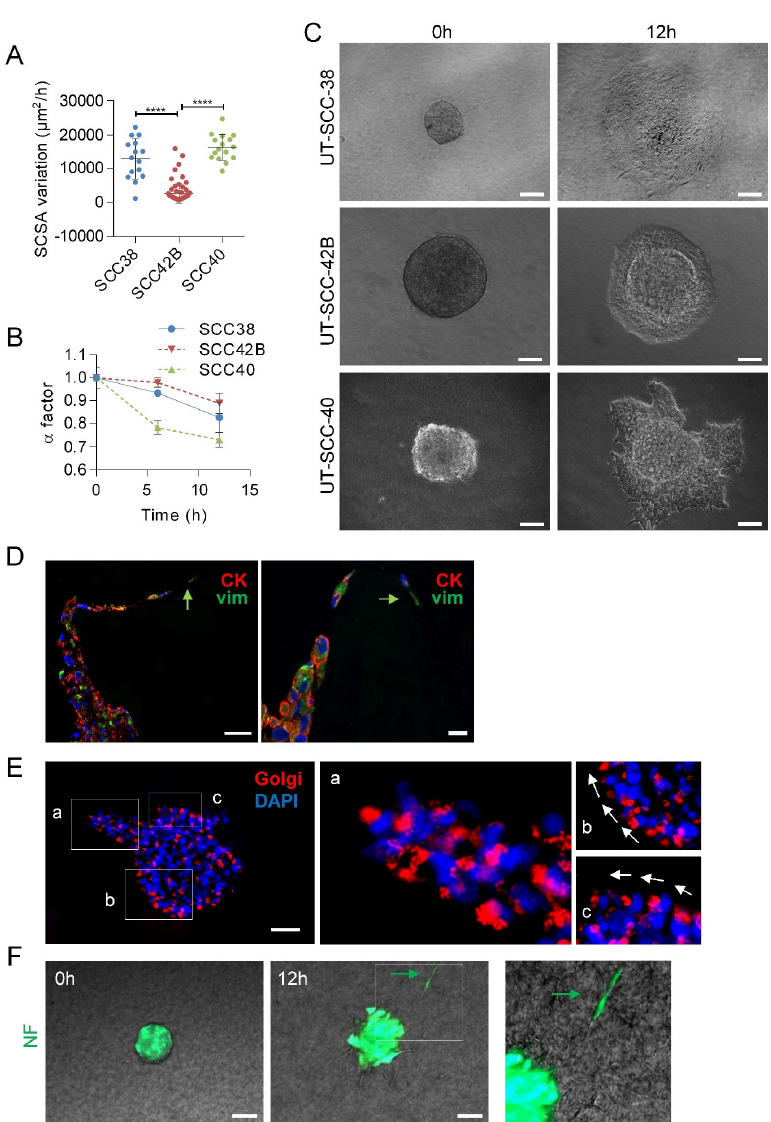
Figure 2. Collective migration of different SCC cell lines showing the driver role of mesenchymal cancer cells over epithelial cells. ( A ) Variations over time of the spheroid cross sectional areas (SCSA) were measured for 12 h in spheroids of the indicated cell lines to calculate the velocity of the migration. Mean and standard deviation values were calculated from 15, 68 and 16 individual spheroids in 3 different experiments for UT-SCC-38, UT-SCC-42B and UT-SCC-40 cells, respectively. **** indicates p < 0.0001. ( B ) Variation over time of the α factor for the indicated cell lines. Data are presented as mean value ± standard deviation from 3 experiments and 10–20 spheroids analyzed in each. ( C ) Representative images of spheroids assembled with the indicated SCC cells at time 0 and after 12 h of incubation. ( D , E ) Representative images of UT-SCC-40 cell spheroids after 24 h of migration immunostained with anti-cytokeratin (red) plus anti-vimentin (green) antibodies ( D ) or anti-58K Golgi protein antibody ( E ). Green arrows denote vimentin positive cells acting as leader of the finger-like cell tracks ( D ). Higher magnification of the areas (a–c) outlined in the left image of panel E are shown at the right to highlight the position of the Golgi apparatus ahead of the nuclei of SCC cells coordinately polarized. White arrows denote the SCC cell’s movement direction. ( F ) Type of migration of non-tumoral fibroblasts (NF) assembled into cell spheroids. Representative images from time-lapse movies of cell spheroids assembled with NFs embedded into a collagen matrix. Cells were labeled with CellTracker green CMFDA before spheroids assembly. Green arrow points to a NF-cell escaping from the cell spheroid. Scale bars: 100 µ m (panels C , F ), 50 µ m (left picture in panel D and panel E ) and 20 µ m (right picture in panel D